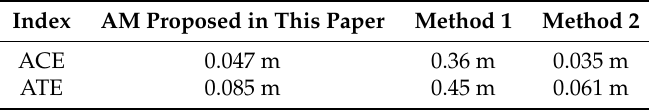
Table 1. Performance Comparison of the Three Candidate